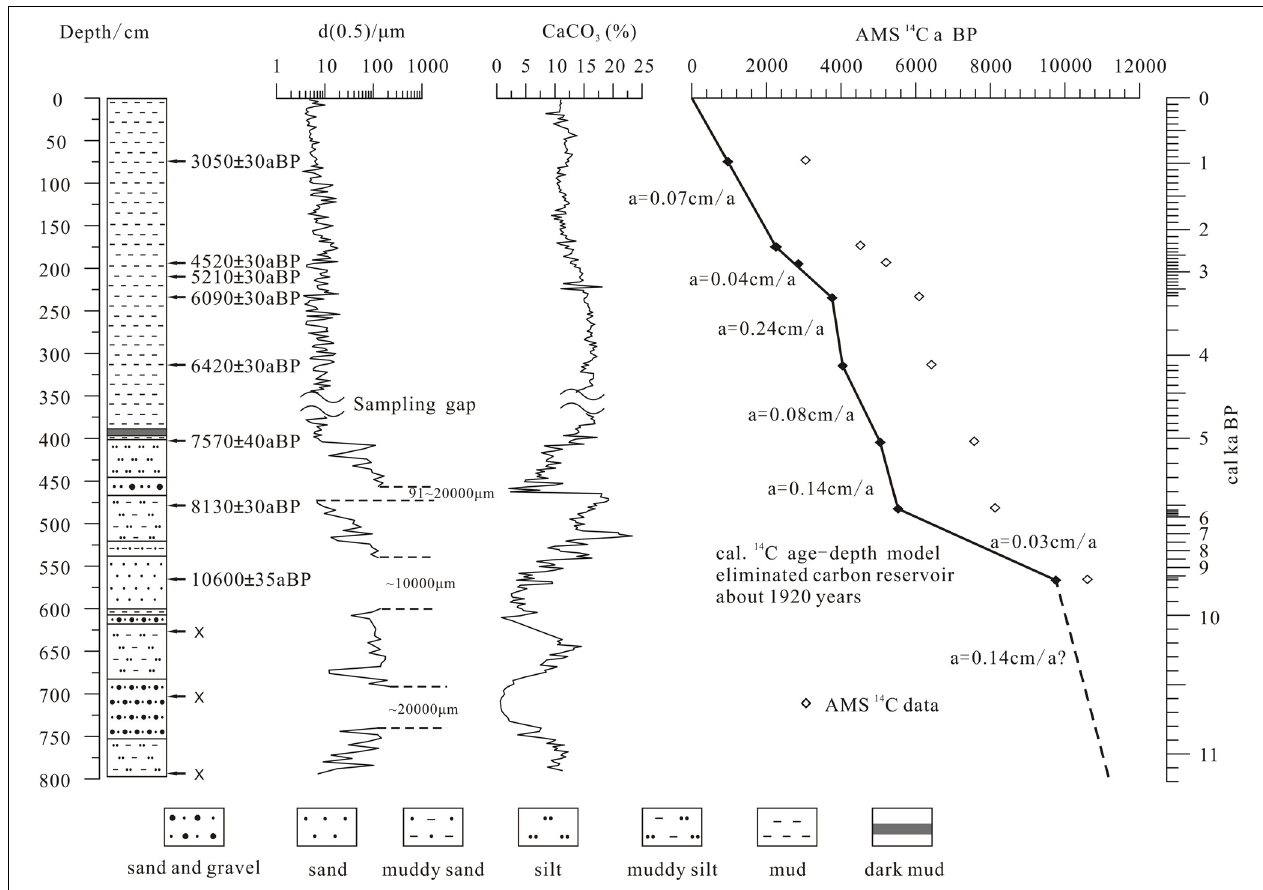
FIGURE 2 | Lithologic section of TGN-05 and the depth-age model based on accelerator mass spectrometry 14 C